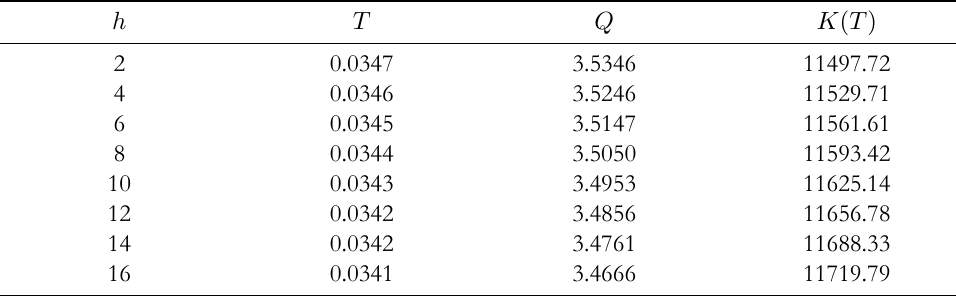
Table 5: Variation in T; Q & K ( T ) with holding cost